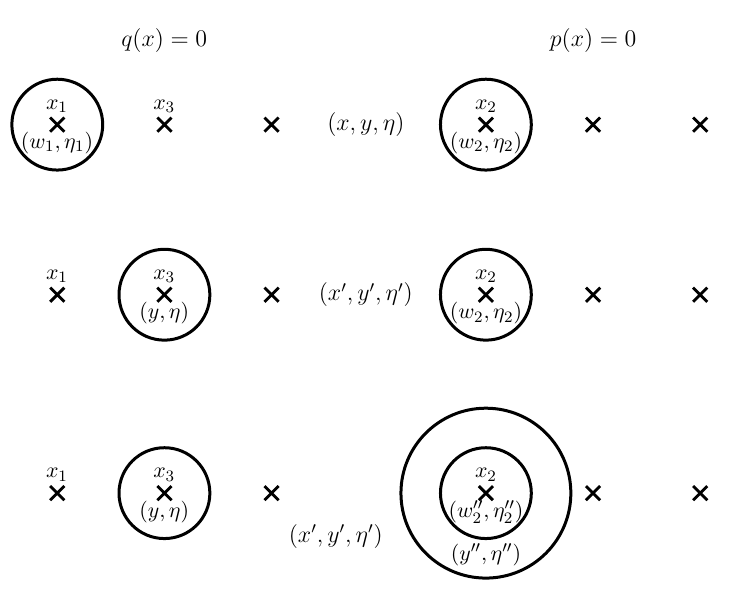
Figure 3 . The top, middle, and bottom diagrams illustrate the unprimed, primed, and double- primed coordinate systems on C ν in the even spin structure case. The six branch points are marked with crosses, with the three q ( x ) = 0 branch points grouped together on the left, and the other three p ( x ) = 0 branch points on the right. Top: the unprimed coordinate system, with ( w 1 , η 1 ) and ( w 2 , η 2 ) parameterizing the discs containing x 1 and x 2 respectively. Middle: the primed coordinate system, which is regular away from x 2 and x 3 . Bottom: the double-primed coordinate system on an annulus surrounding x 2 , whose transition maps into the disc coordinates ( w 00